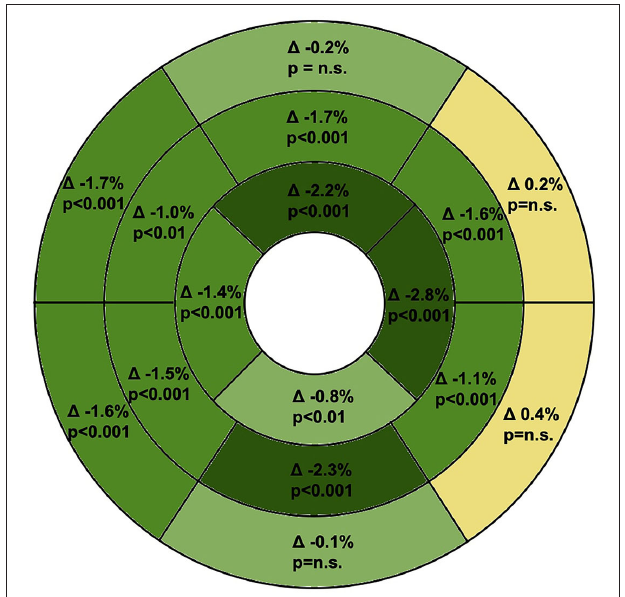
FIGURE 5 | Response of segmental 1 LS after DHE visualized in the AHA 16-Segment model bullseye. LS significantly increased in every midventricular and apical segment. Yellow, 1 LS > 0.0%; bright green, 1 LS 0.0 to –0.9%; green, 1 LS –1.0 to –1.9%; dark green, 1 LS ≤ –2.0%. LS, longitudinal strain; DHE, dynamic handgrip exercise; AHA, American Heart Association.